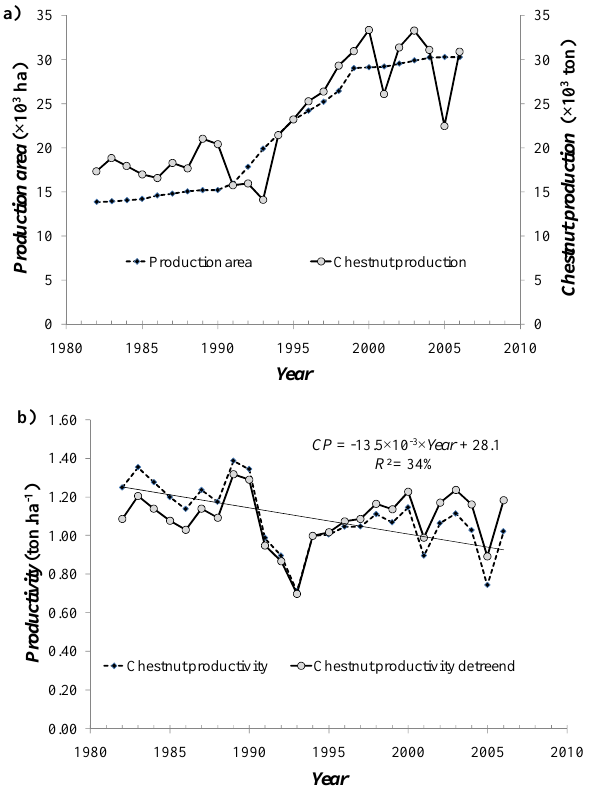
Figure 3. Observed values of: a) chestnut production, (in ×10 3 ton) and production area (in 3 Fig. 3. Observed values of: (a) chestnut production, (in × 10 3 ton) ×10 3 ha); and, b) chestnut productivity and detrended chestnut productivity (in ton.ha -1 ), in 4 and production area (in × 10 3 ha); and, (b) chestnut productivity and Portugal. Colocar (a) e (b) nas figuras superior e inferior, respectivamente. 5 detrended chestnut productivity (in tonha − 1 ) , in Portugal.